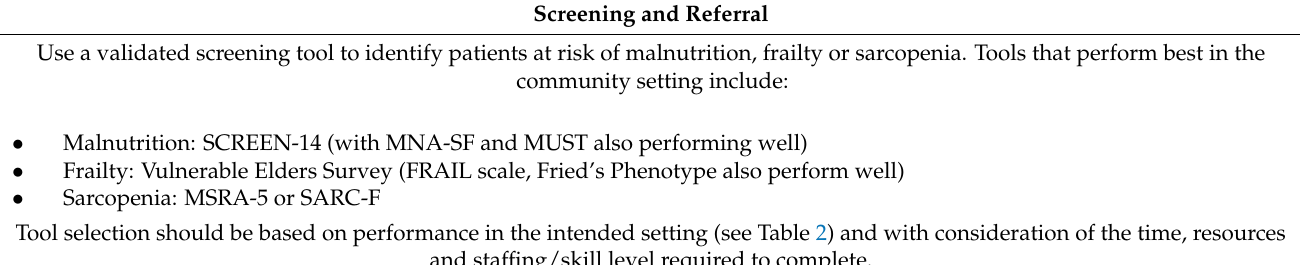
Table 6. Recommendations for the nutritional management of malnutrition, frailty and sarcopenia. Screening and